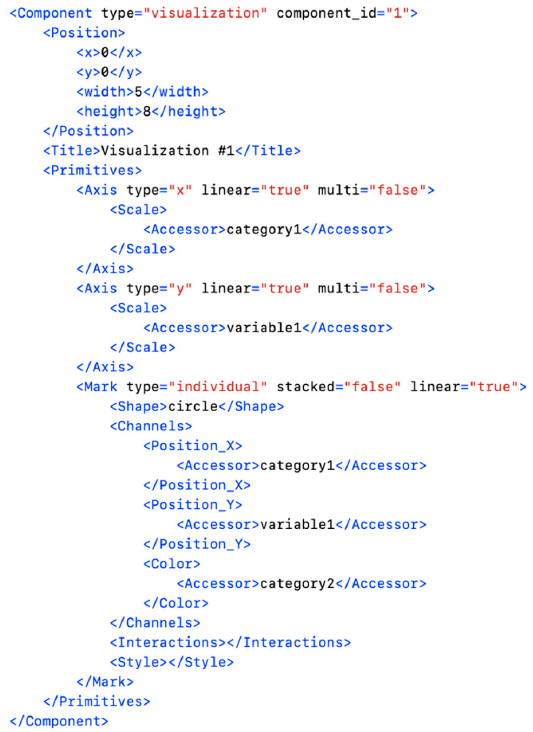
Figure 6. Configuration of a scatter chart using the DSL.